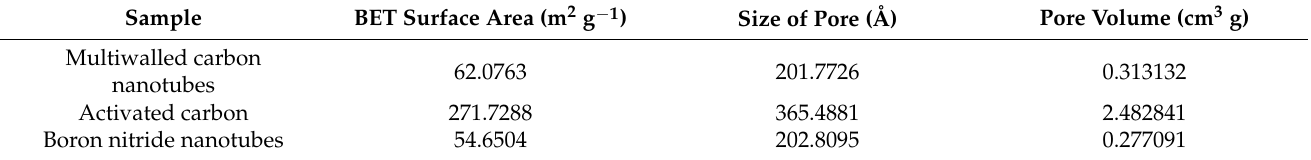
Table 1. Physical properties of activated carbon, multiwalled carbon nanotubes and boron nitride nanotubes.